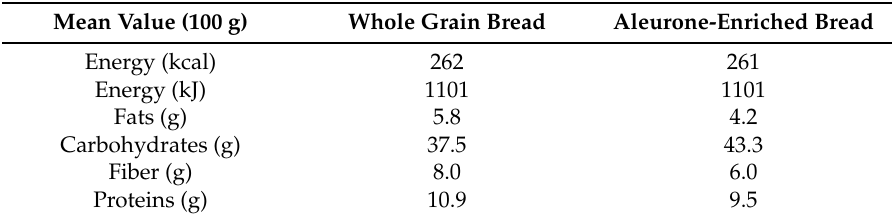
Table 1. Nutrient composition of the two